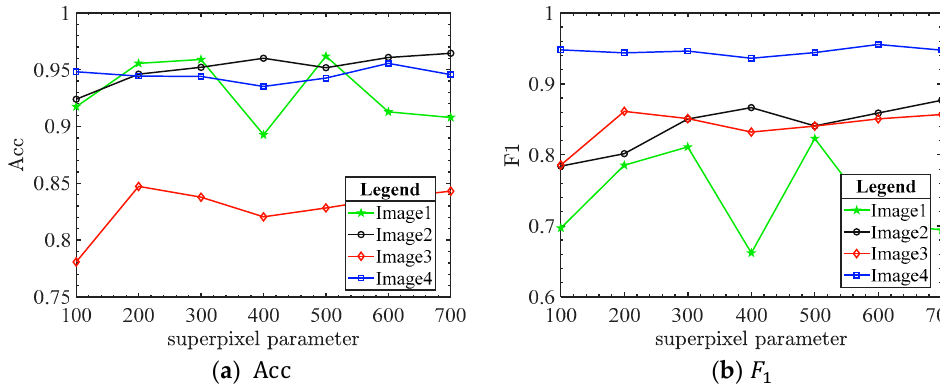
Figure 5. Relationship between the evaluation criteria (Acc, F 1 ) and superpixel parameter on TSDPC.